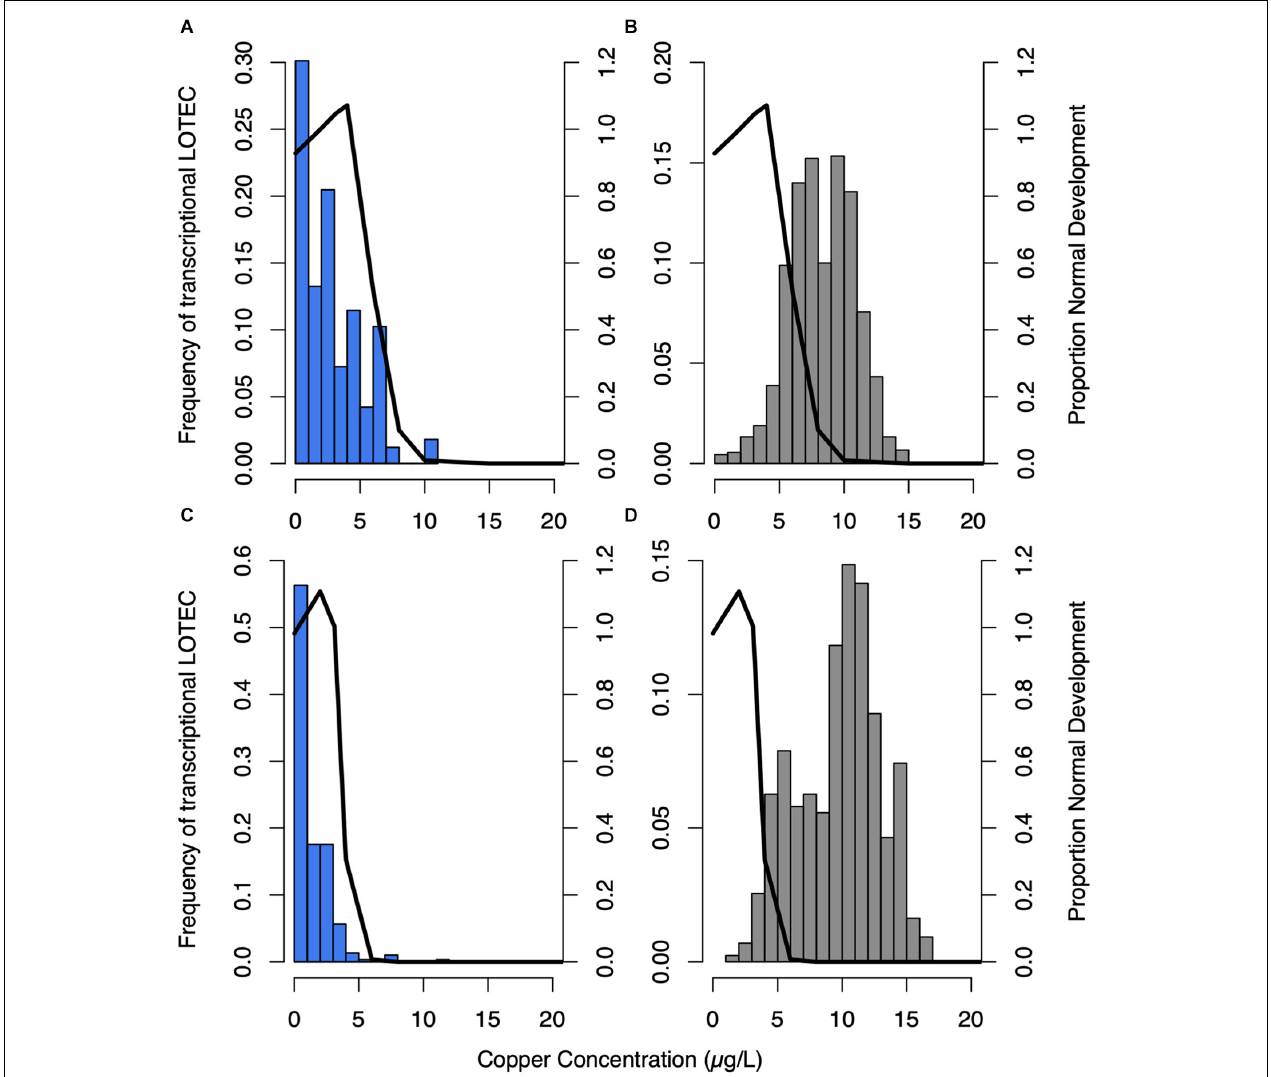
FIGURE 3 | The frequency of sigmoidal genes’ lowest observed transcriptional effect concentration (LOTEC) was plotted as a histogram for downregulated genes in blue - trials 1 (A) and 2 (C) , and upregulated genes in gray - trials 1 (B) and 2 (D) . These values were compared to normal development (black line) in each trial. LOTEC thresholds are more sensitive indicators of copper-induced expression changes than EC50 values, which is evidenced by the shift toward lower copper concentrations compared to frequency histograms of EC50 values ( Supplementary Figure S4